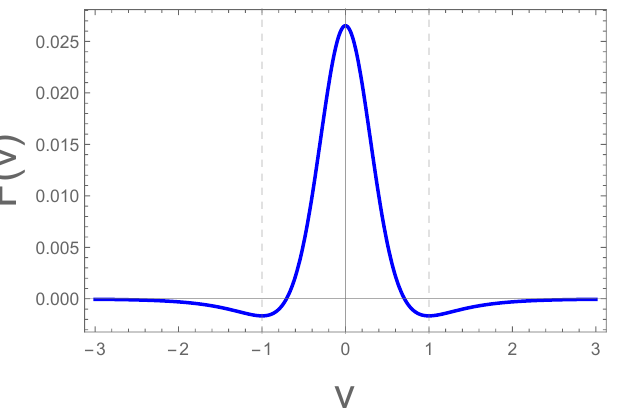
Figure 4. The energy flux, Equation (13), is asymptotically zero at v = ± ∞ . The total energy, as we shall see in Equation (16), is therefore finite, E = κ /96. Notice the emission of negative energy flux near early and late advanced times. The maximum flux F max = κ 2 / ( 12 π ) occurs at v = 0 and the minimum flux F min = − κ 2 / ( 192 π ) occurs at v = ± 1/ κ . The energy flux crosses zero, F = 0, at √ v = ± 1/ ( 2 κ ) . Here κ =